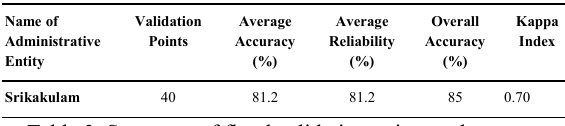
Table 3. Summary of flood validation points and